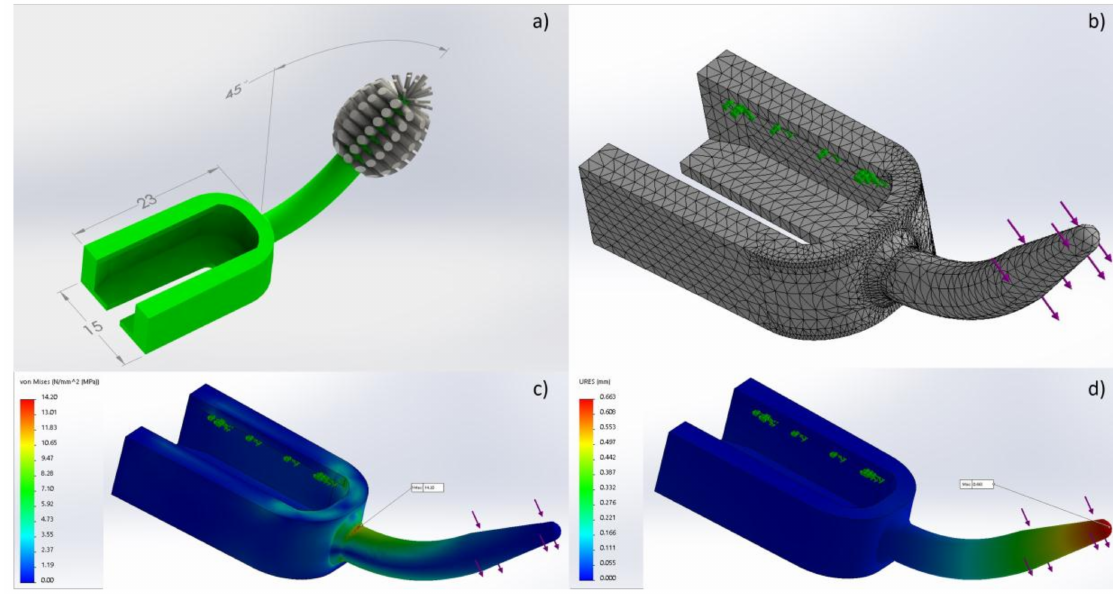
Figure 2. ( a ) Cleft Toothbrush—3D model; ( b ) finite elements solid mesh; ( c ) results of the stress in the Cleft Toothbrush due to the applied load (maximum of 14.20 MPa at the connection between the